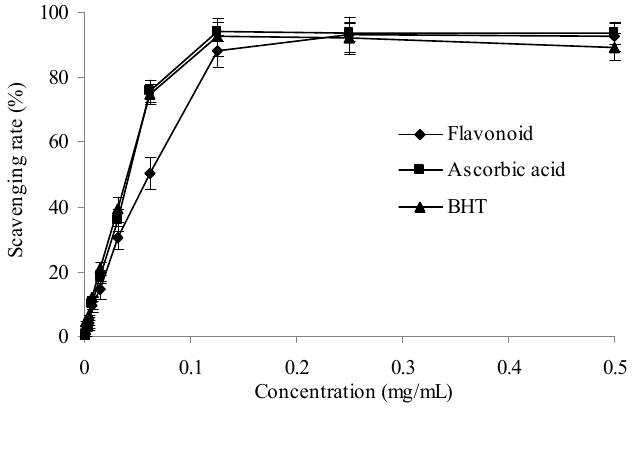
Figure 4. ABTS radical scavenging activities of sample and control standards, Each value is expressed as a mean ± S.D (n =